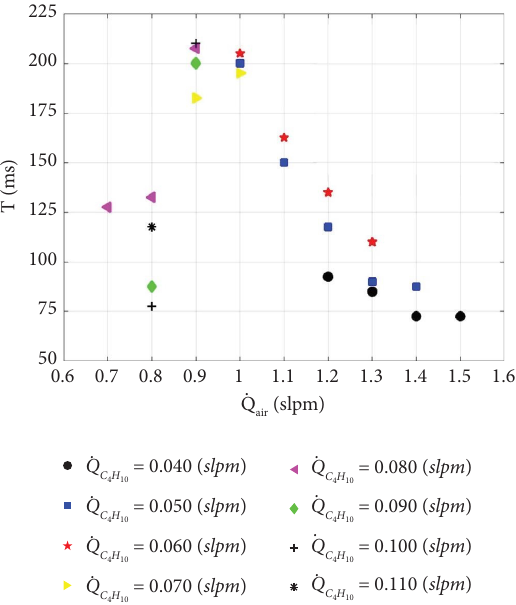
Figure 6: Periods of oscillatory